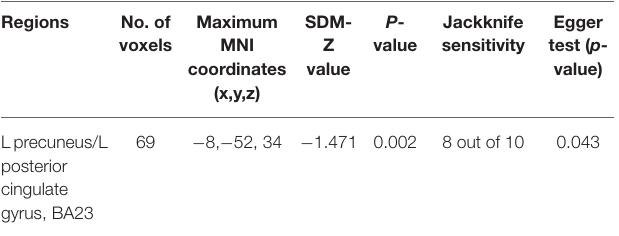
TABLE 2 | The main meta-analysis: Gray matter volume reductions in ET patients relative to healthy controls. Regions